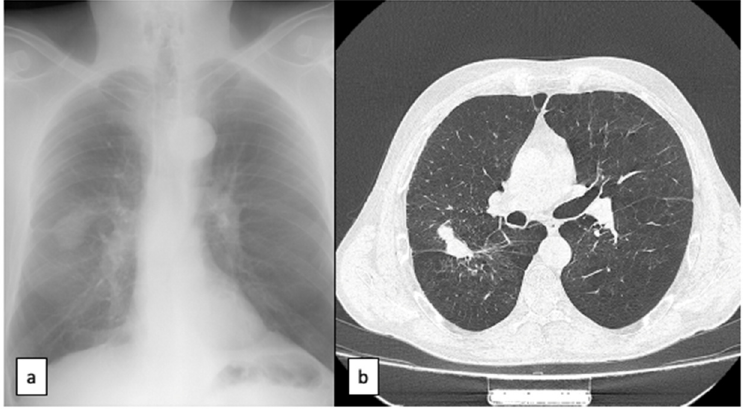
Figure 4. Control after 1 year (2022): ( a ) chest radiography; and ( b ) CT scan showing resorption of hematoma with chronicization of lesion, lack of other lung lesions—important remaniation.